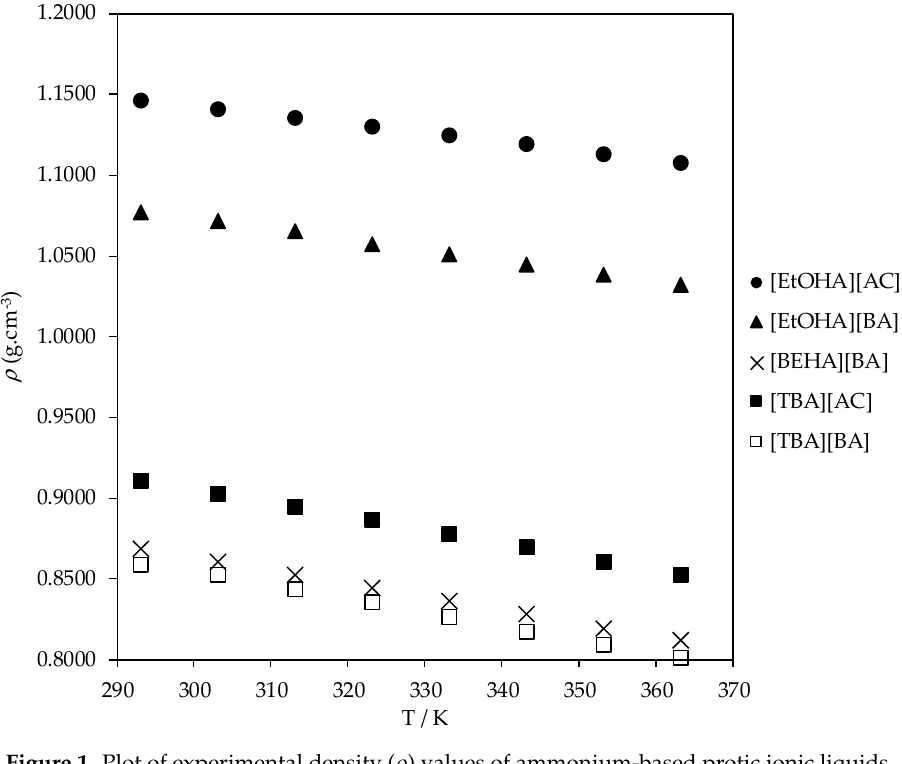
Figure 1. Plot of experimental density ( ρ ) values of ammonium-based protic ionic liquids.